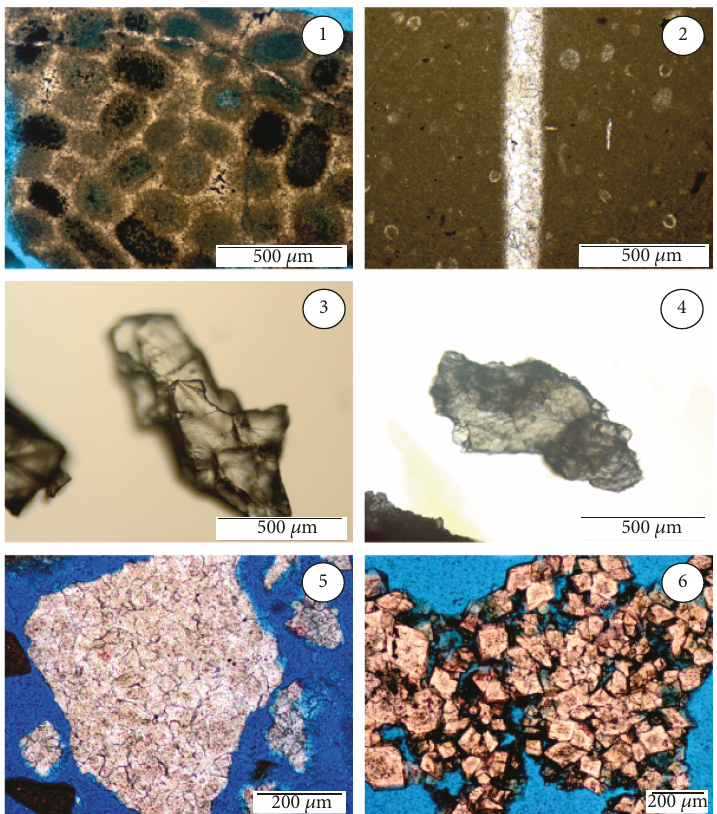
Figure 5: Overview of the facies types: (1) gray to beige limestone (massive facies), (2) brown limestone (bedded facies), (3) transparent vein calcite, (4) white vein calcite, (5) beige interlocked dolostone, and (6) beige sugar-grained